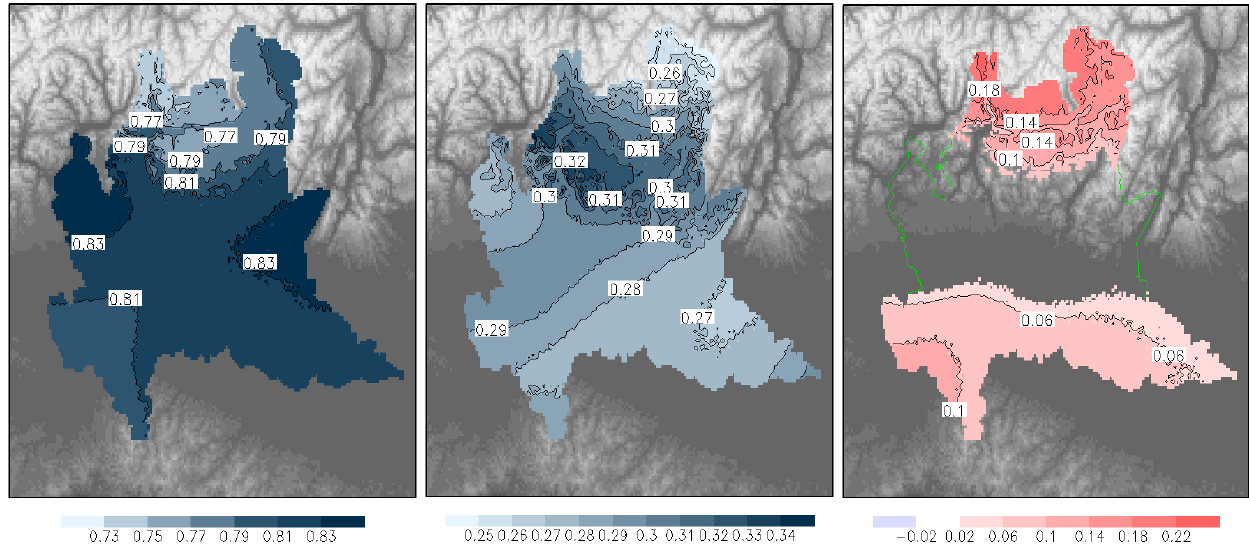
Fig. 5. Maps of the estimated GEV parameters ε (location, left) α (scale, centre) and ξ (shape, right), all dimensionless. In the ξ map, the red scale shows positive values, corresponding to a Fréchet distribution; the (not appearing) blue scale would show negative values, corresponding to a reverse Weibull distribution. Values of the ξ mean that are smaller, in absolute value, than the standard deviation are masked out: in such areas the GEV distribution is considered equivalent to a Gumbel